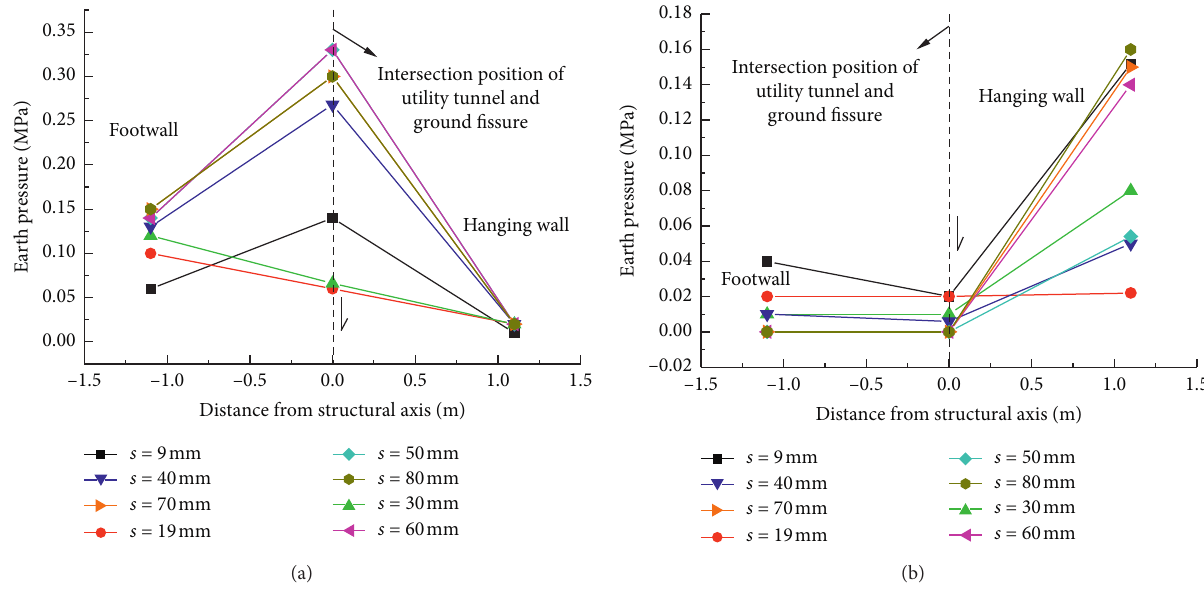
Figure 12: Transverse earth pressure curve on bottom of structure. (a) Transverse earth pressure curve on bottom of structure, the intersection of the ground fissure and the axis of the utility tunnel structure to the hanging wall at 0.8m. (b) Transverse earth pressure curve on bottom of structure, the intersection of the ground fissure and the axis of the utility tunnel structure to the footwall at 0.8m.